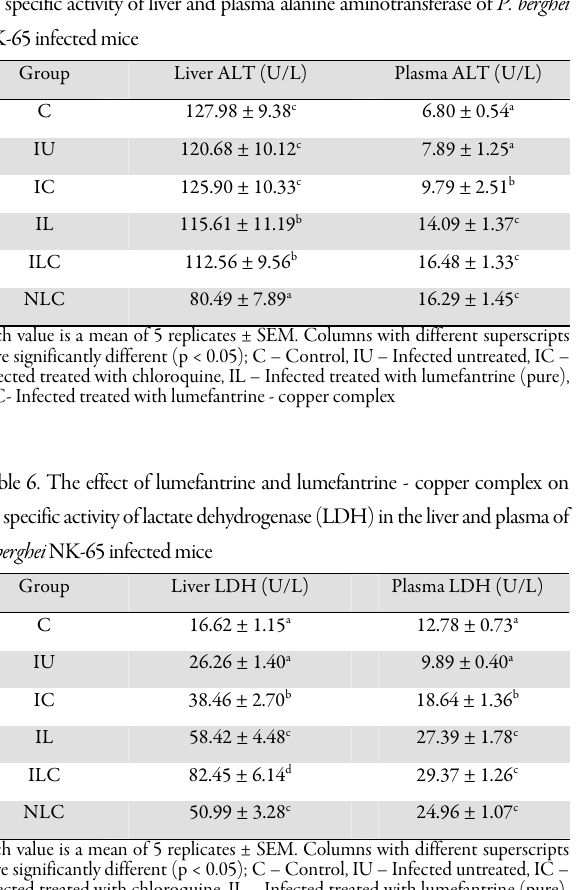
Infected treated with chloroquine, IL – Infected treated with lumefantrine (pure), ILC- Infected treated with lumefantrine - copper complex